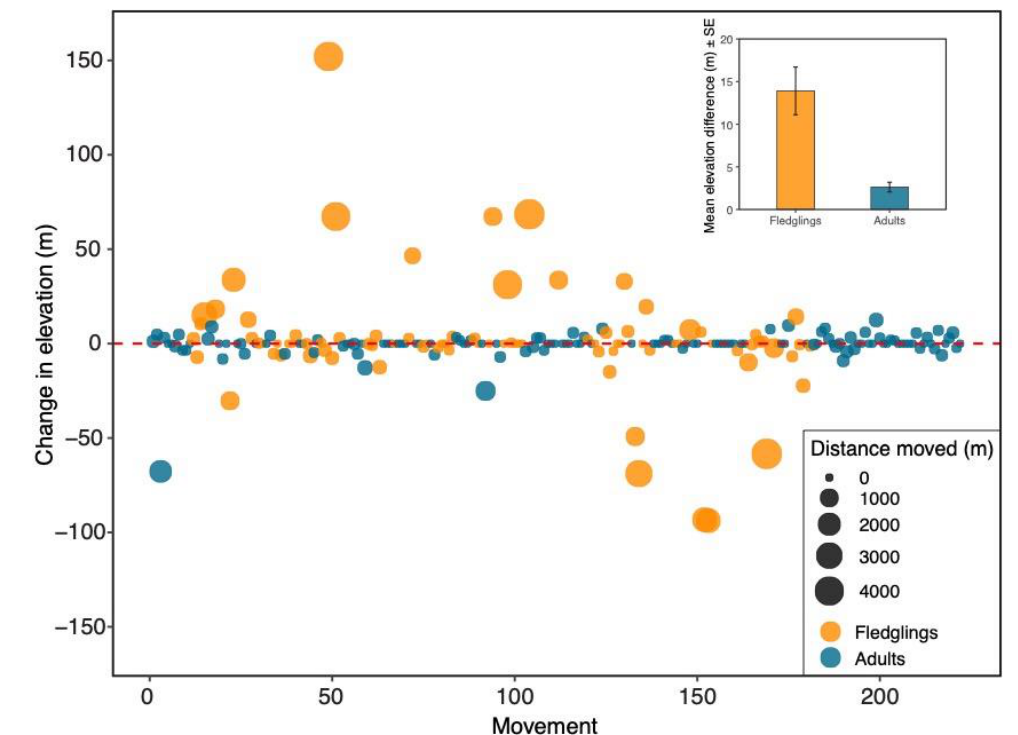
Figure 2. Age differences in elevational changes between nesting locations from one year to the next for each bird captured two or more times ( n = 222). Each point represents an individual bird movement. An individual can have multiple points if it was captured more than two times. Orange circles depict a bird that was banded as a fledgling, and blue circles depict adults. The size of each point corresponds to the straight-line distance between nest boxes. Inset: Mean (±SE) elevation difference (absolute values) between fledglings and adults. Fledglings changed elevation more than adults (LMM: estimate = −8.48 ± 1.83, df = 90.97, t = −4.64, p < 0.001).